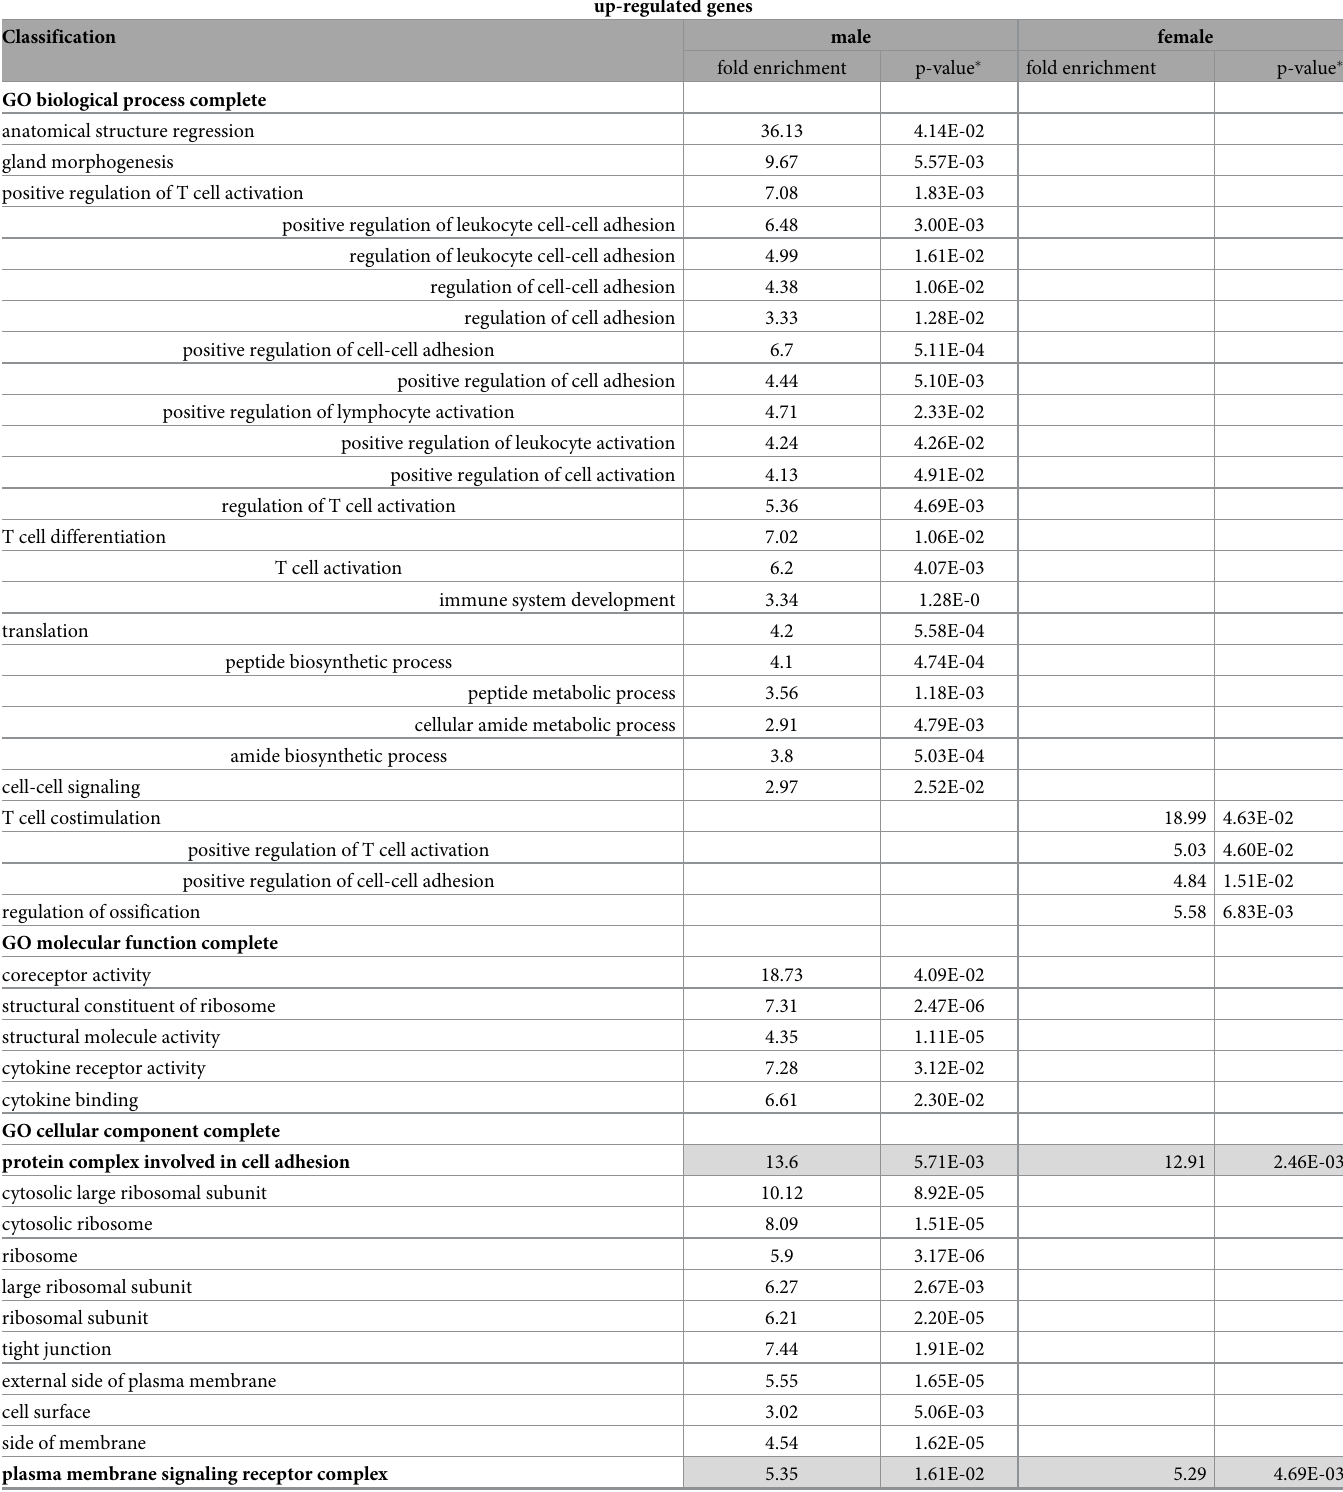
Table 1. Gene ontology (Panther) classification of differentially expressed